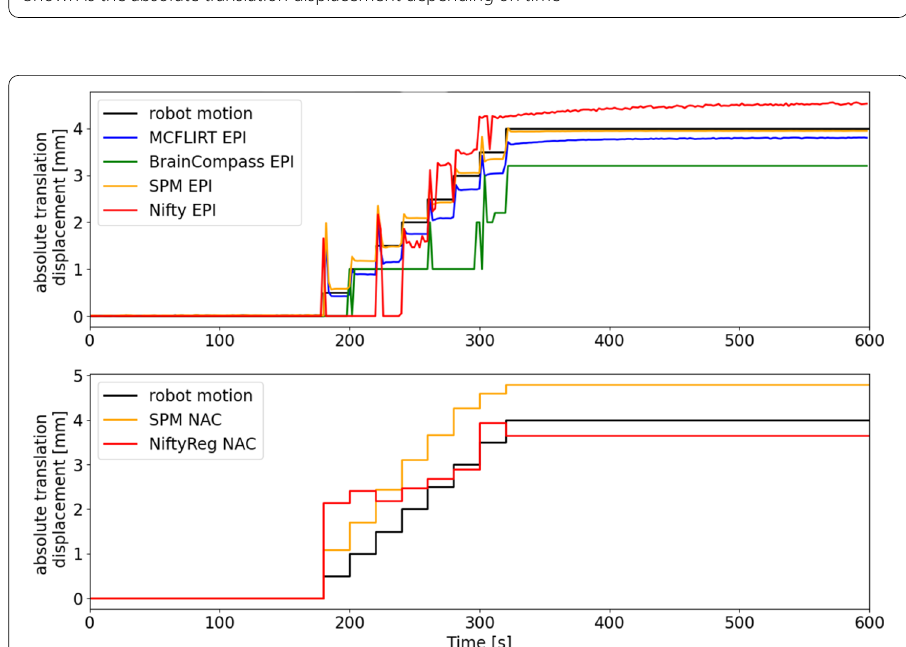
Fig. 12 Comparison of different registration methods of multiple translation movements. The robotic movement (black line) symbolizes the ground truth. Upper image: EPI-based; lower image: NAC-based. Shown is the absolute translation displacement depending on